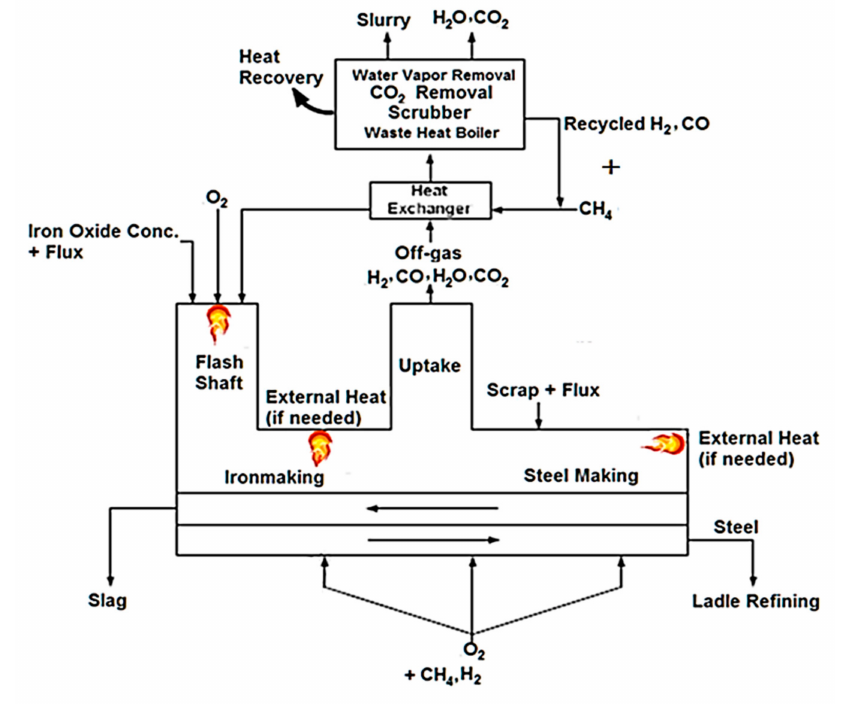
Figure 1. Flash Ironmaking Process. (Concept first proposed by H. Y. Sohn in a research proposal submitted to U.S. Department of Energy through American Iron and Steel Institute (AISI) in November 2003. The figure is adapted from Sohn and coworkers